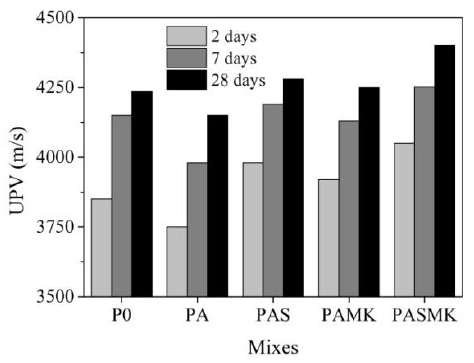
Figure 9. The variation of UPV in samples P0 – PASMK samples for 28